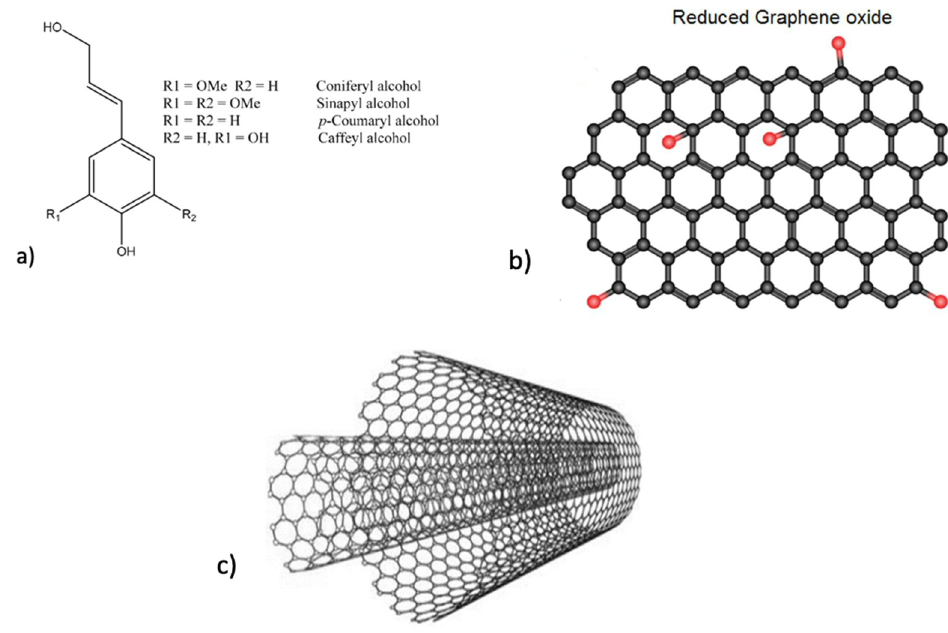
Figure 1. Structures of ( a ) lignin [22], ( b ) GO [42] and ( c ) MWCNTs [43].